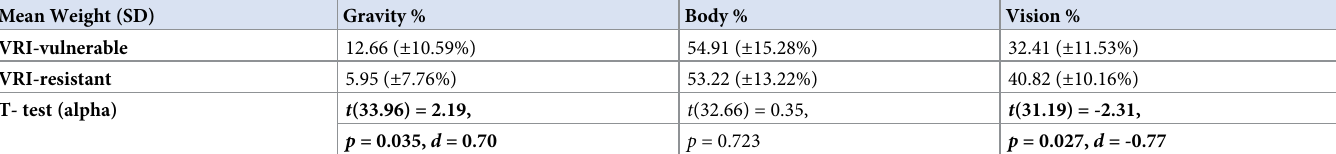
Table 1. The results of the three t-tests comparing sensory weight between the VRI-vulnerable and VRI-resistant groups. The average relative contribution of each cue in determining the PU is given as a percentage. The numbers in brackets are the standard deviation. The columns are the three cues, the rows are the VRI group. The alpha denotes the significance value from the t-test, with the bolded alphas indicating a result with a p less than 0.05. Mean Weight